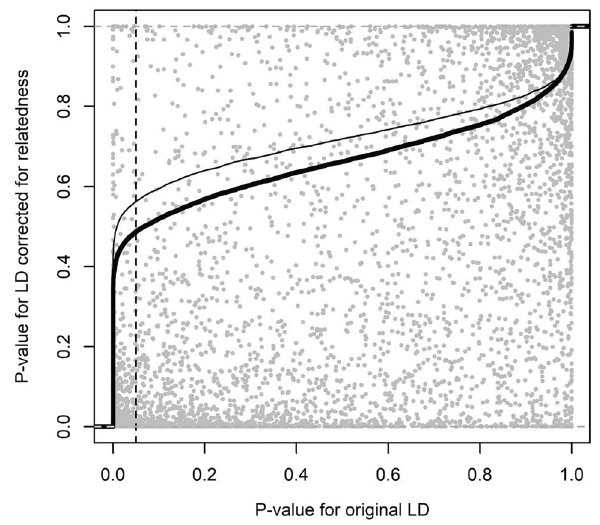
Figure 2. Correspondence in p-values from Jennrich test (test for difference in LD pattern between POP1GF and POP1HD) using original LD (including familial relatedness effect) and LD corrected for bias caused by familial relatedness. The thick line represents cumulative distribution of p-values for differences in LD pattern between scaffolds from POP1GF and POP1HD using unbiased LD estimate while thin line is cumulative distribution of p values for the same test using original LD (including effect of familial relatedness) Dashed line represents the threshold for statistically significant test.